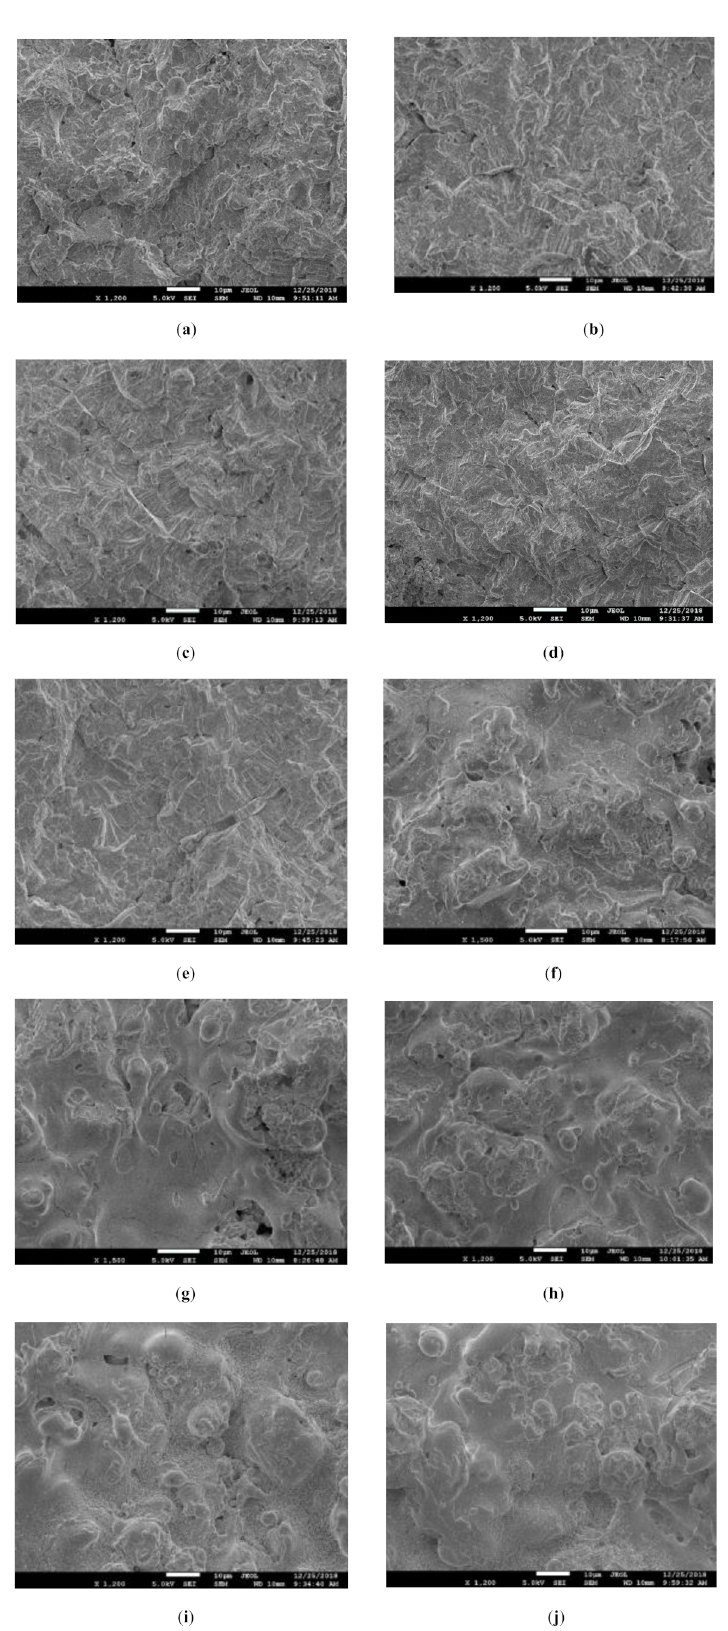
Figure 7. Scanning electron microscope diagrams of thermal barrier coatings under high temperature exposure: ( a – e ) are surface morphologies for 0, 2, 5, 10 and 20 h, respectively; ( f – j ) are cross sectional morphologies for 0, 2, 5, 10 and 20 h,